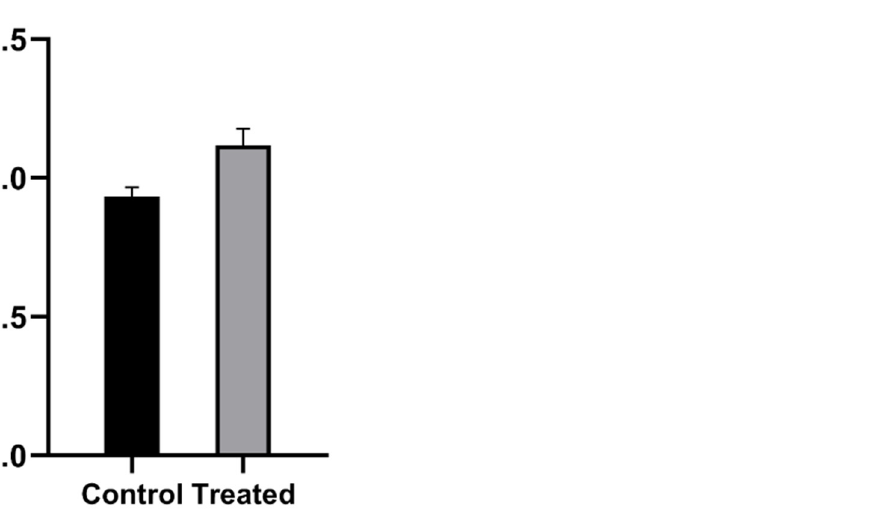
Figure 9. Absorbance at 250 nm of 50 mL samples untreated (Control) and treated with plasma for 30 min (Treated). Student’s t -test, p < 0.05.